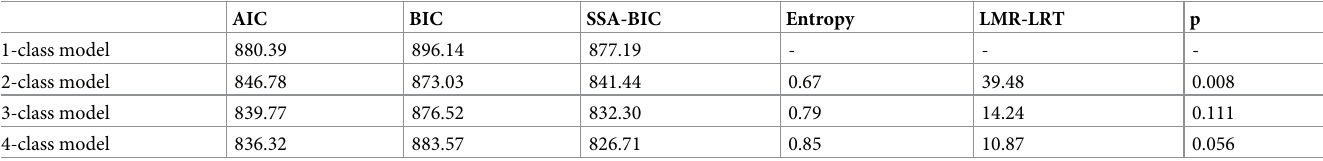
Table 1. Model fit indices for models with different number of latent classes (N = 102). AIC BIC SSA-BIC